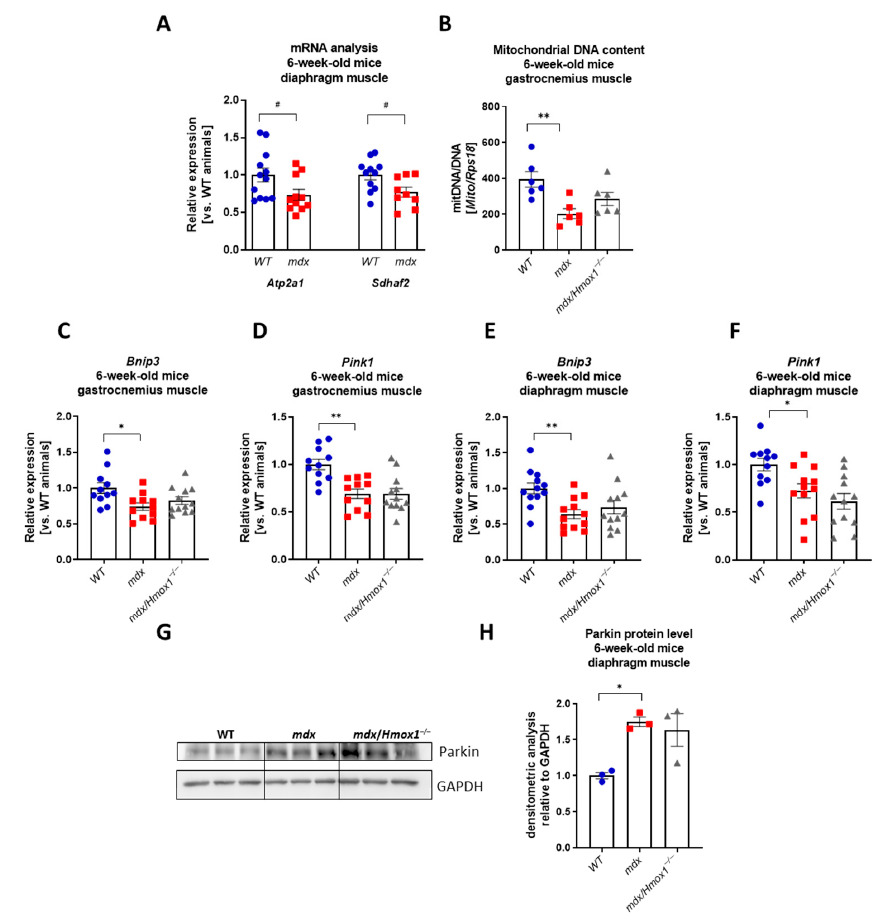
Figure 4. Genes and proteins regulating mitochondrial homeostasis in 6-week-old mice. mRNA level of Atp2a1 and Sdhaf2 in 6-week-old WT and mdx mice analyzed by qRT-PCR ( A ); n = 9–12/group. Decreased mitochondrial DNA content in mdx mice ( B ), qRT-PCR, n = 6/group. Analysis of the mRNA level of Bnip3 and Pink1 genes regulating mitophagy in gastrocnemius ( C , D ) and diaphragm ( E , F ) muscles from WT, mdx , and mdx / Hmox1 − / − genotypes, qRT-PCR; n = 11–12/group. Western blot analysis of Parkin protein ( G ) and densitometric analysis of Parkin level in diaphragm muscle ( H ), n = 3/group. GAPDH was used as a loading control. Results presented as mean ± SEM. # p < 0.05 with Student’s t -test * p < 0.05, ** p < 0.01 by one-way ANOVA with Tukey’s post hoc